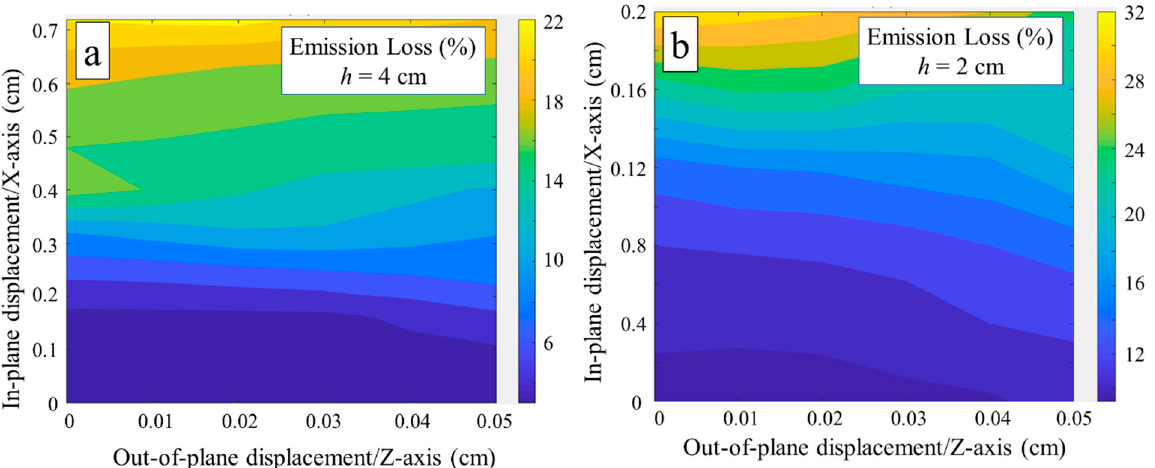
Figure 10. The percentage of emission loss as a function of in-plane and out-of-plane displacement due to the volume distribution of luminescent dye along the focal line for c = 5 cm, O = 1 mm, and ( a ) h = 4 and ( b ) h = 2 cm.